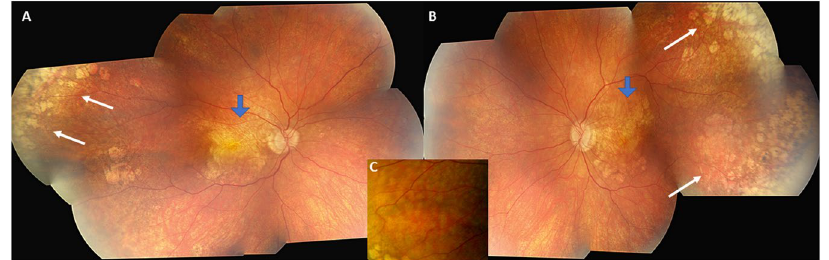
Figure 1. Fundus photographs of a 56-year-old woman with an EMAP disease. Visual acuity is 20/400 in both eyes. ( A , B ) There is a bilateral and symmetrical extensive geographic macular atrophy with a diameter larger in vertical than horizontal (beneath blue arrows) in both eyes (A right and B left-eye). Atrophic lesions are also noted in the far peripheral and temporal retina in both eyes (white arrows). The extension of the macular atrophy and the association with peripheral small patches of atrophy is not common in AMD. ( C ) Color- magnified photograph of the midperipheral retina that reveals the striking density of pseudodrusen.